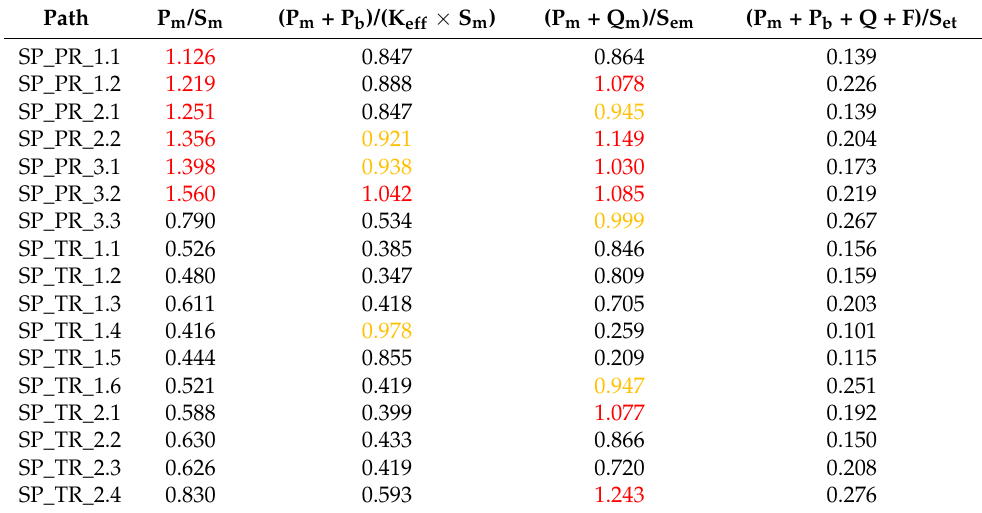
Table 6. RCC-MRx Level D criteria verification within SPs